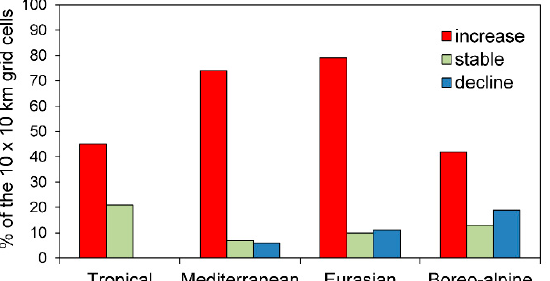
Figure 5. Percentages of 10 × 10 km grid cells (total 67.374 grid cells) where the number of European dragonfly (Odonata) species increased, decreased, or remained unchanged from 1988 to 2010, separated into biogeographic groups (Tropical, Mediterranean, Eurasian, and Boreo-alpine).